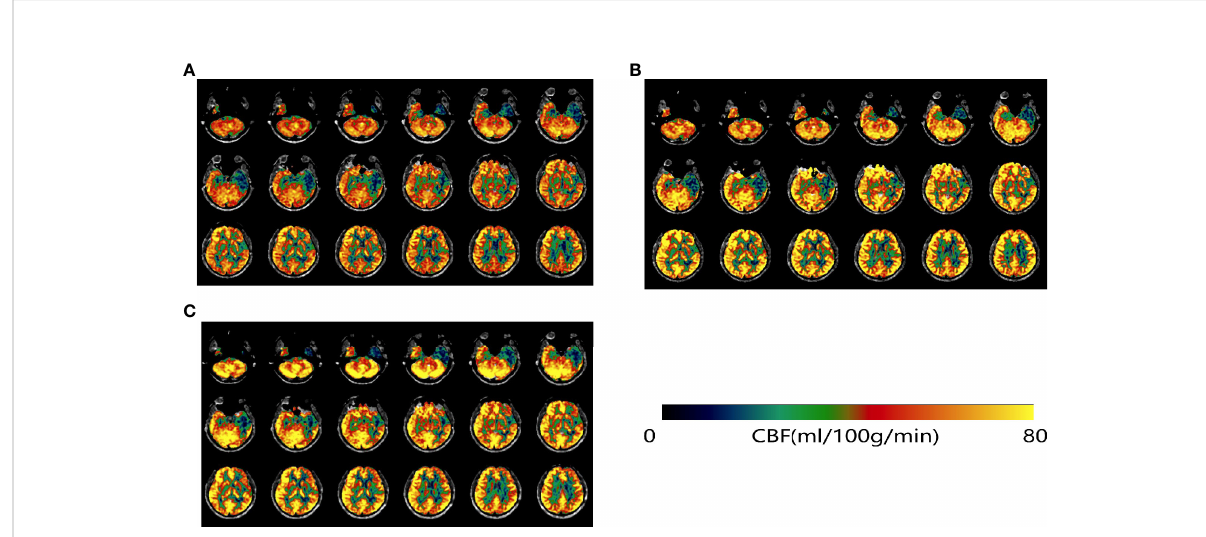
FIGURE 2 ASL-MRI on 9 February 2021 before GV-971 treatment (A) , 29 July 2021 (B) , and 18 January 2022 (C) . After treatment with GV-971 (B, C) , regions of low perfusion in green were visibly